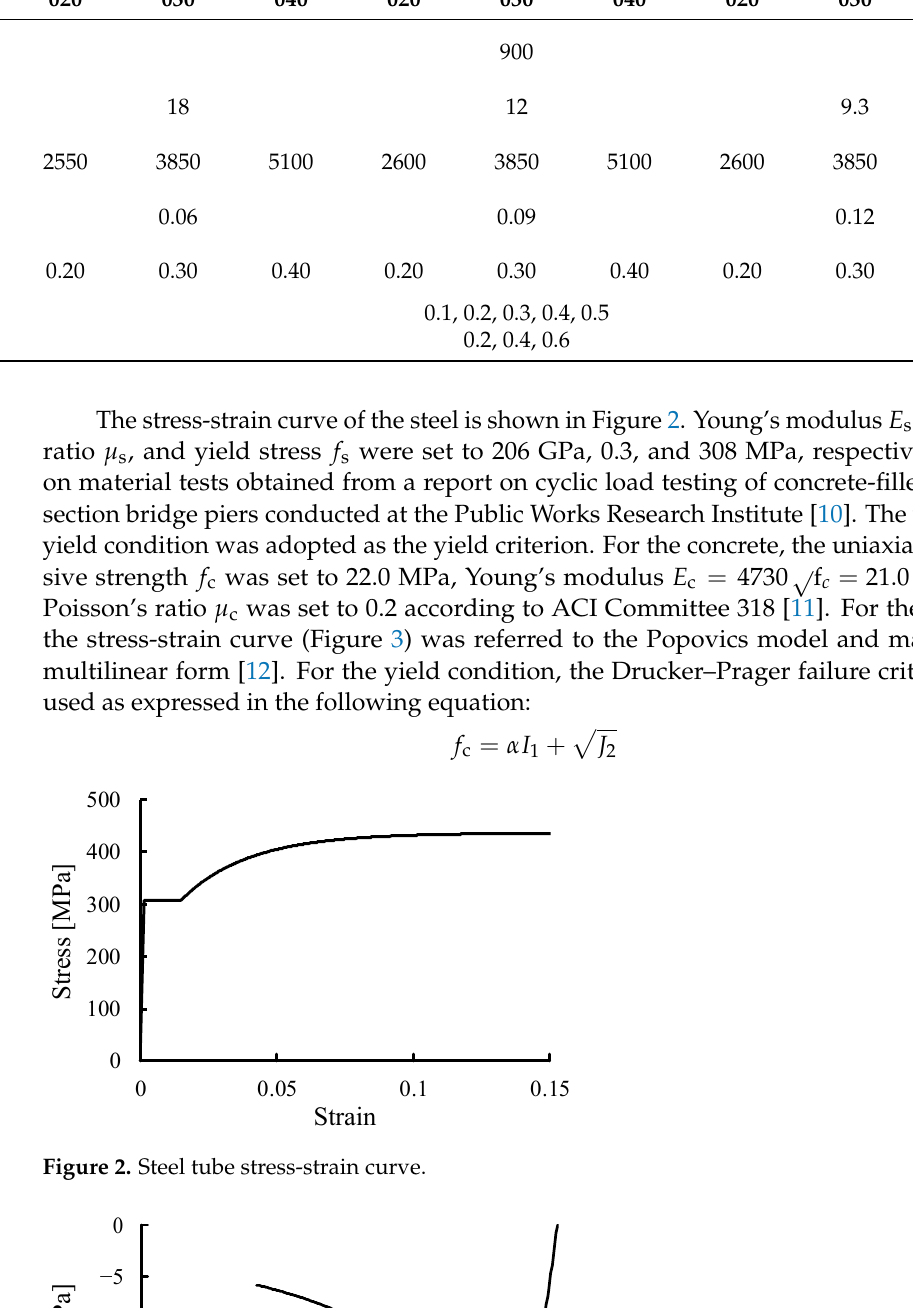
Table 1. Numerical model specifications.